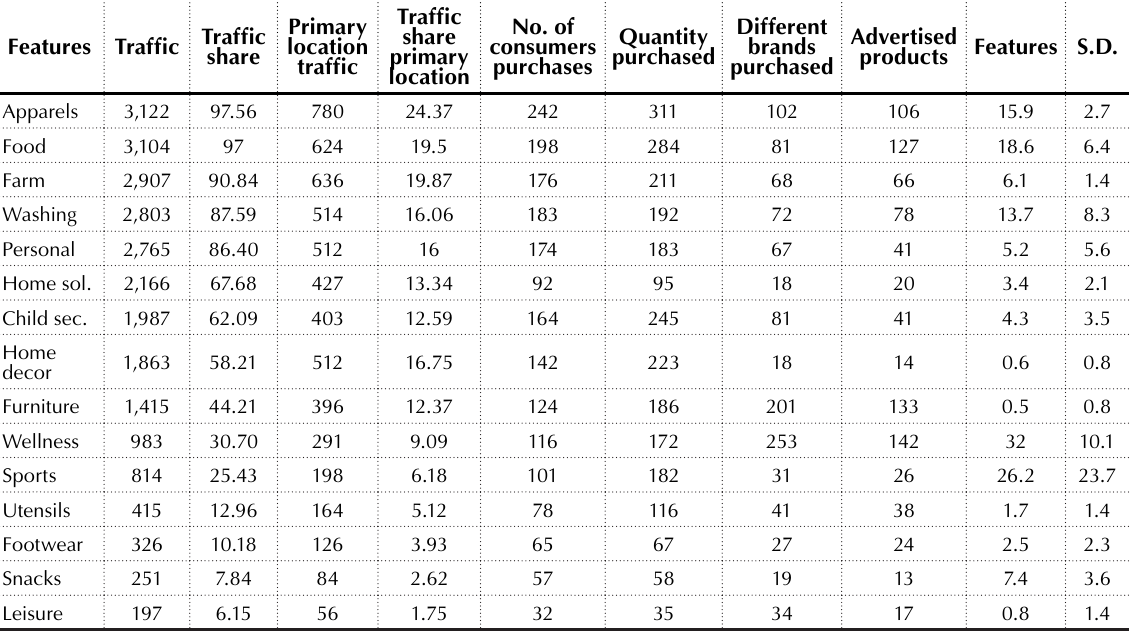
Table 1. Traffic, sales and ads in various categories Traffic Features Traffic